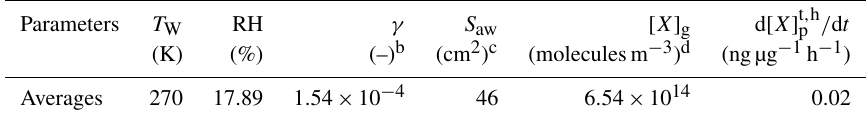
Table 3. Calculating the theoretical heterogeneous uptake rate of H 2 O 2 on aerosols (d [ X ] t , h p / d t ) a .